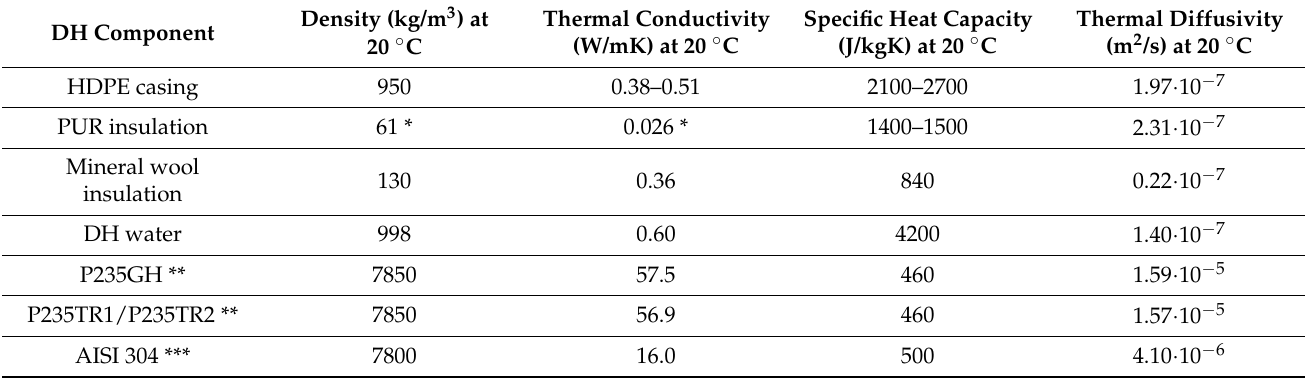
Table 2. Material properties of polyurethane (PUR) [12–14], high-density polyethylene (HDPE) [15], and carbon and stainless steels used in DH networks [15]. Thermal diffusivity is calculated from the table values. Thermal Conductivity Specific Heat Capacity Thermal Diffusivity Density (kg/m 3 ) at DH Component (W/mK) at 20 ◦ C (J/kgK) at 20 ◦ C (m 2 /s) at 20 ◦ C 20 ◦ C HDPE casing 950 0.38–0.51 PUR insulation 61 * 0.026 * Mineral wool